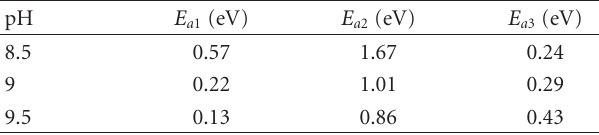
Table 1: The values of activation energies for Cd 1 − x Zn x S prepared at di ff erent pH